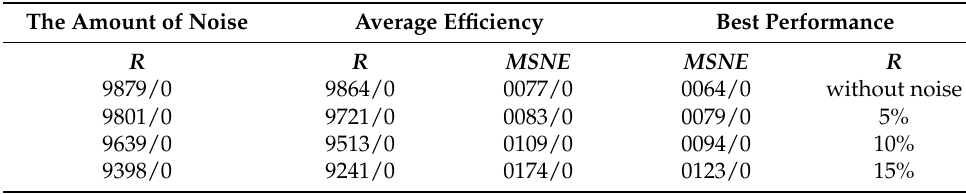
Table 1. CPU workload predictor neural network